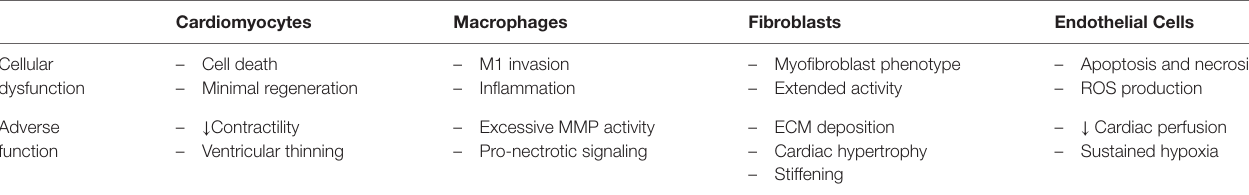
TABLe 2 | Cell responses and functional changes